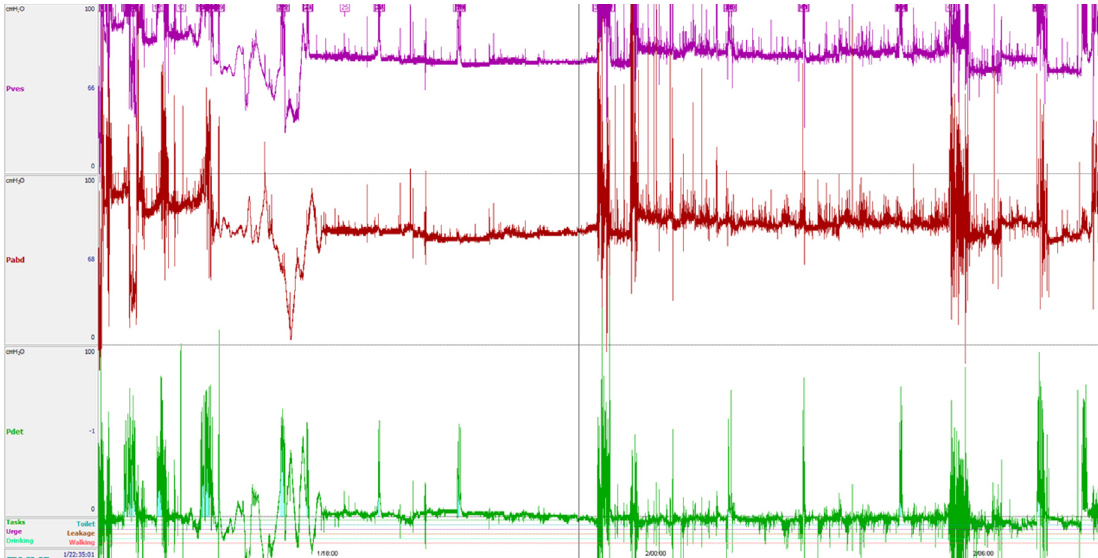
Figure 9. A typical cystometry curve from ambulatory urodynamics using a portable data logger from Medical Measurement Systems (Enschede, The Netherlands). The unit along the y ‐ axis is cmH 2 O, the unit along the x ‐ axis is the time of day (in hours). Bladder pressure ( P ves ) is shown in the upper part and reference abdominal pressure ( P abd ) in the middle. The lower curve is the calculated detrusor pressure ( P det ). Detrusor activity is difficult to identify, even in an expanded graph.